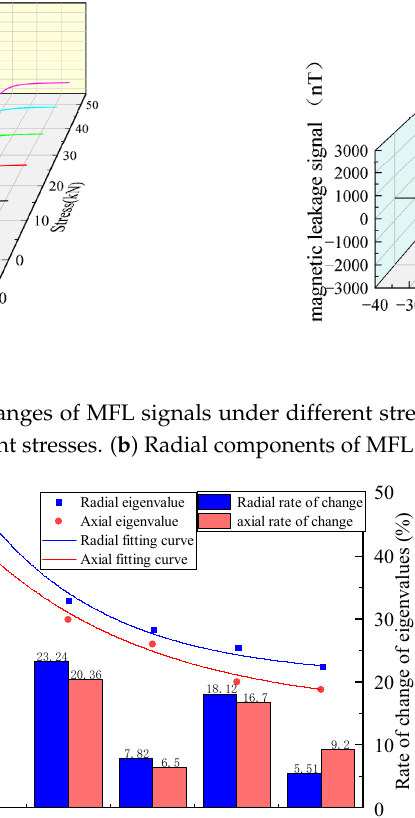
Figure 7. Relationship between stress and eigenvalue at the defect .